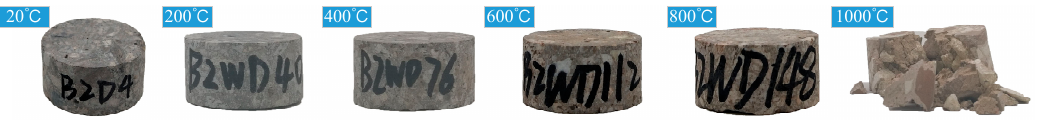
Figure 4. The appearance characteristics of the specimens after exposed to different temperatures.